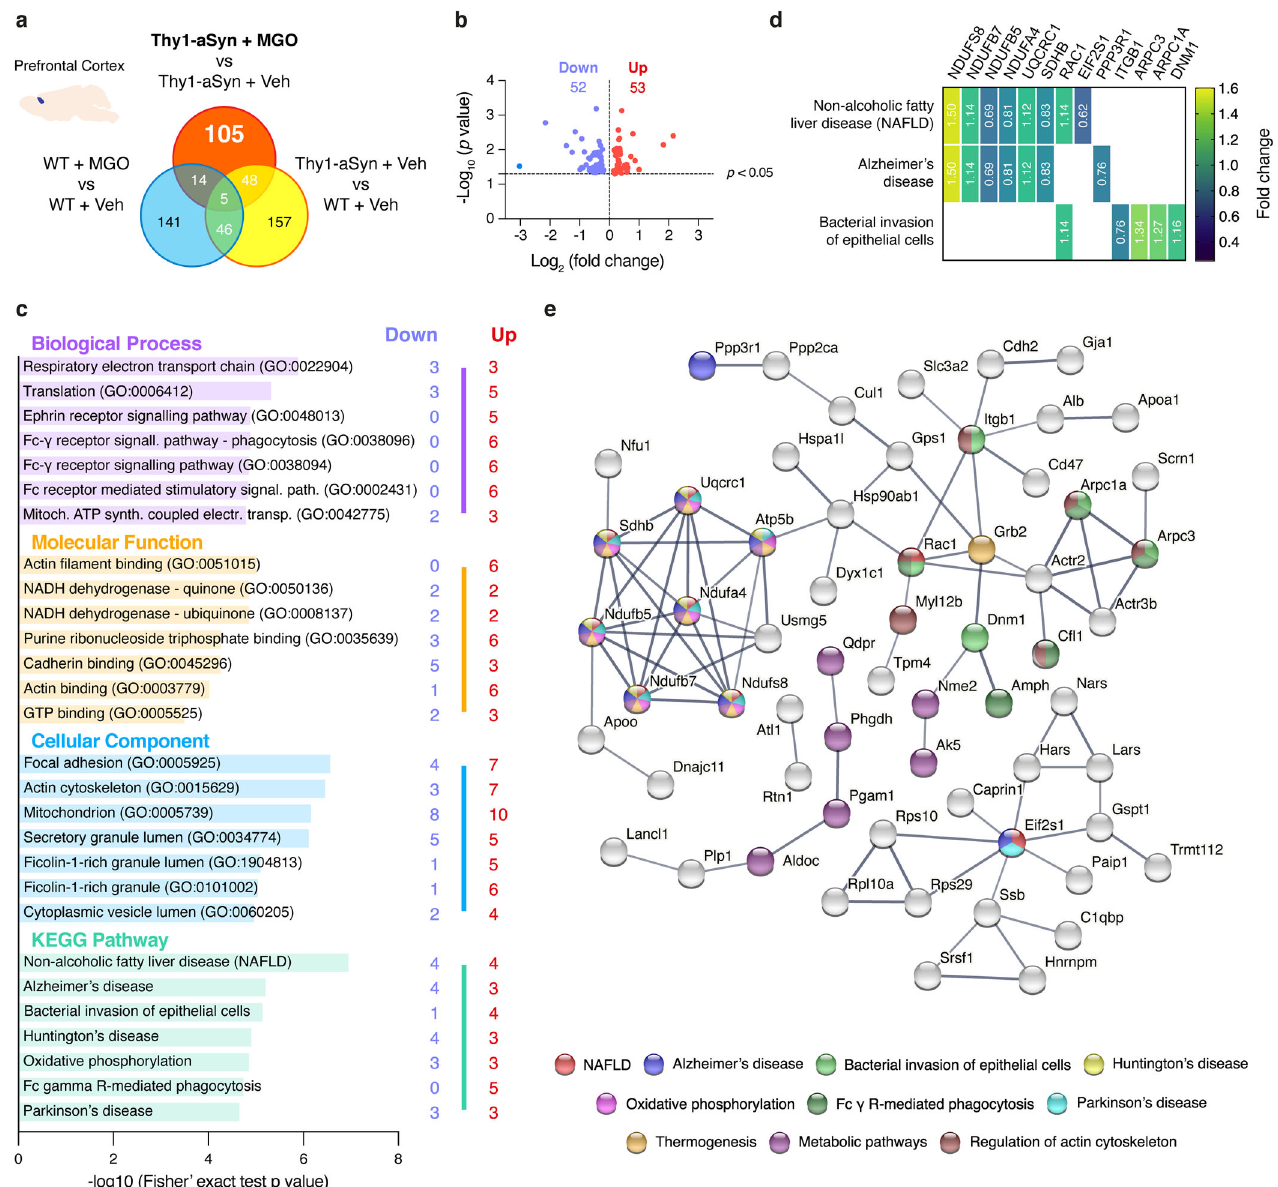
Fig. 5 MGO-treatment alters components of the respiratory electron transport chain in the prefrontal cortex of Thy1-aSyn mice. Proteomic differences between cortical proteins from WT or Thy1-aSyn mice injected with vehicle or MGO. a Venn diagram depicting unique and shared midbrain proteome between pairwise comparisons of Thy1-aSyn mice injected with MGO and vehicle, Thy1-aSyn mice and WT mice both injected with vehicle and WT mice injected with MGO and vehicle. b Volcano plot for unique hits of Thy1-aSyn mice injected with MGO and Vehicle. Statistically signi fi cant down- and upregulated hits are presented. c KEEG pathways and Gene Ontology (GO) terms analysis is presented, depicting the number of down- and upregulated unique hits. Distribution of − log 10 (Fisher exact test p value) is shown. d Heatmap of the uniquely altered proteins corresponding to the top 3 altered KEGG pathways. e Protein – protein interaction networks of uniquely altered proteins, extracted from the STRING 11.0 database. Only the proteins that are interacting within a network are show. KEGG pathways or GO Biological processes are color